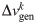
Combination of SNP influences for the 213 individual genotypes.(A) The scatterplot for the genotype score Δvgenk vs. the sum ∑SNPΔvSNPk of the SNP scores over all SNPs from the genotype, for all genotypes and values of k corresponding to contribution from two or more SNPs from the same regulatory region. The blue color labels points with a prevailing influence from only one SNP within a genotype, and the red color corresponds to the competition from multiple SNPs, as described in the text. The threshold value (70% of the largest SNP score) chosen to discriminate the blue and red points was manually tuned to make the red points comprise all points outside the additivity line (S5 Fig shows the deviation from this line as a function of this threshold). The panel shows the magnified graph for better visualisation, and the inset displays the full range. (B) Measure of SNP influence additivity for the population (green line) in comparison with the same measure for families of genotypes randomly simulated under the neutral SFS (red) and the population-derived SFS (blue). The measure is the mean distance from the points (x,y)=(∑SNPΔvSNPk,Δvgenk) to the line of pure additivity y = x, as explained in the text. The distances were calculated for all k values related to a genotype (1 ≤ k ≤ 3400) and for 213 polymorphic genotypes from the population or from a family of randomly simulated genotypes, and an average value was obtained for the population and for each family. For each SFS type, the probability density function (PDF) was estimated from the mean distance distribution across 100 families of randomly simulated genotypes.